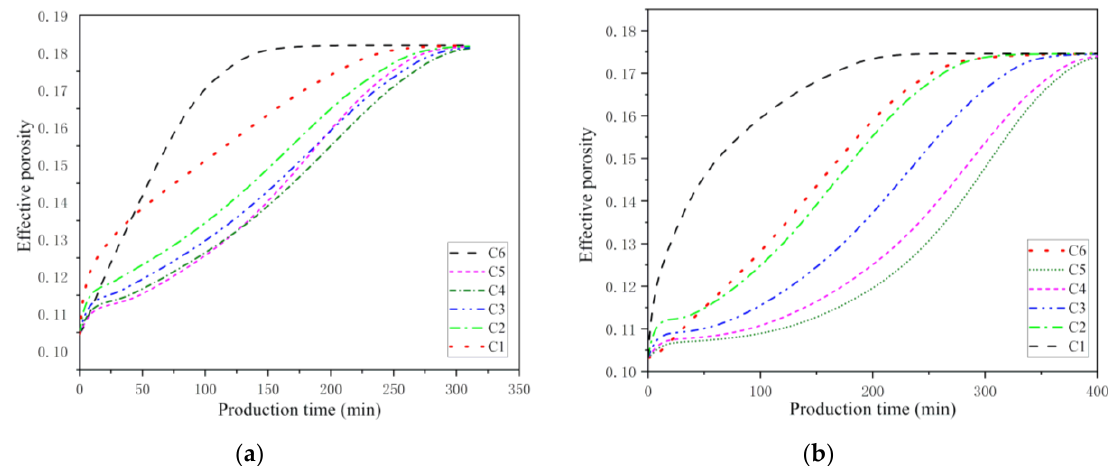
Figure 9. Effective porosity variation with production time for the mechanical ( a ) uncoupled and ( b ) coupled models.